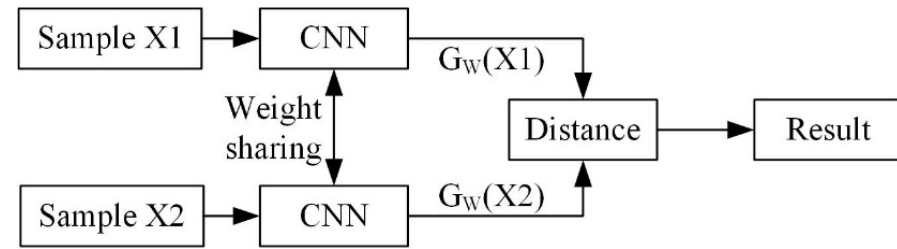
Figure 3. Siamese network architecture.